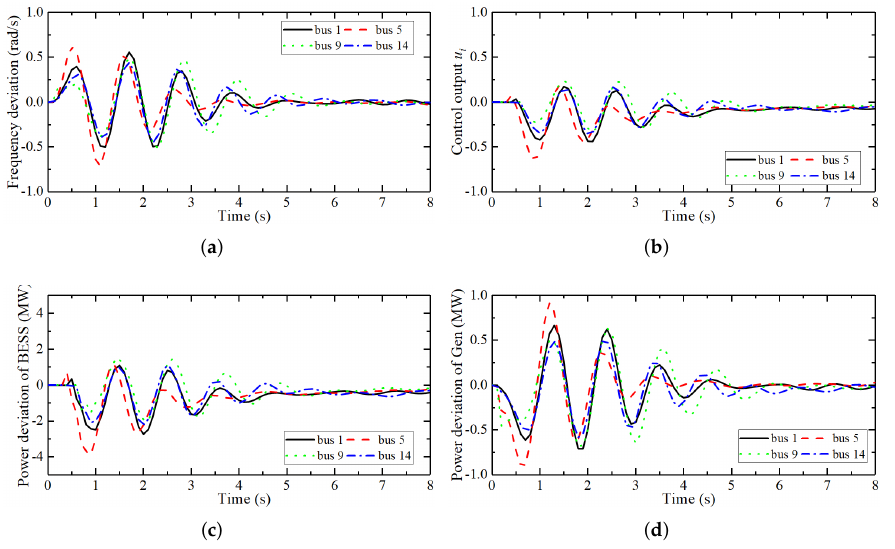
Figure 7. Frequency deviation, control output, BESS and power output deviation of the generator in IEEE14 bus testing system, η ji = 0.05. ( a ) Frequency deviation. ( b ) Control output u i . ( c ) Power deviation of BESS. ( d ) Power deviation of generators.